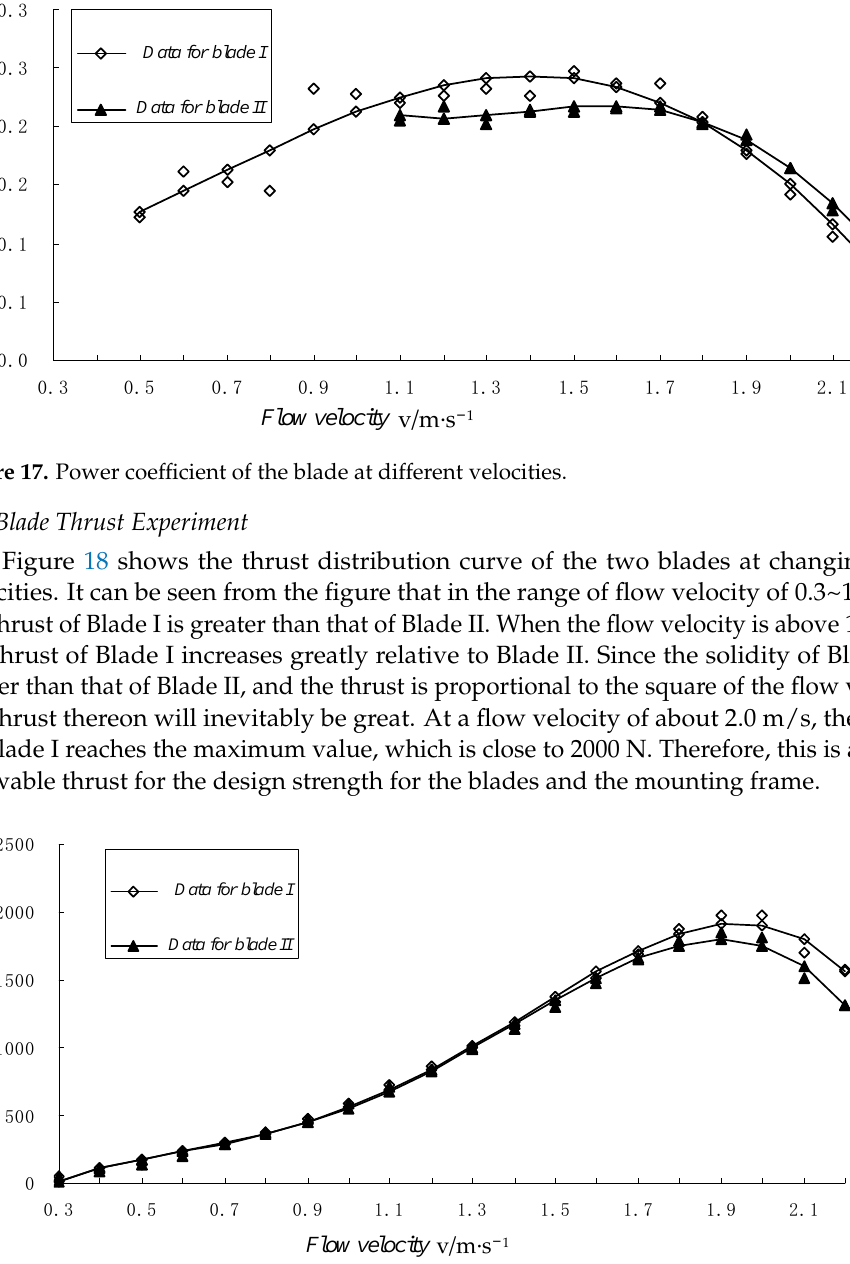
Figure 18. Thrust of the blade at di ff erent velocities.